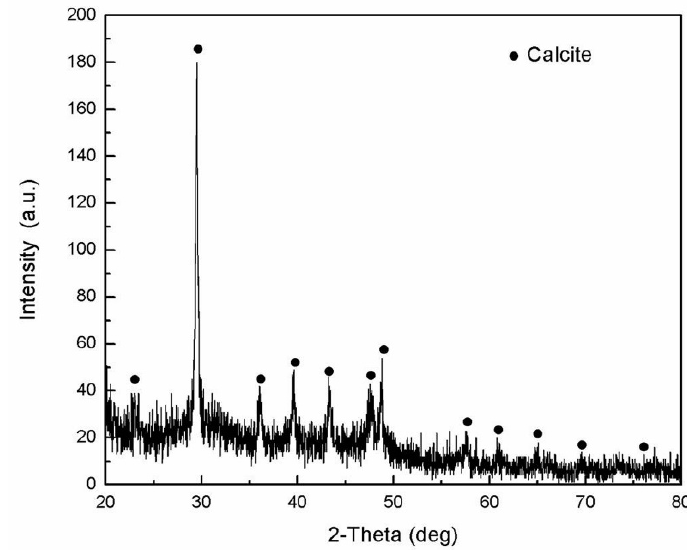
Figure 10. Results of XRD analysis.